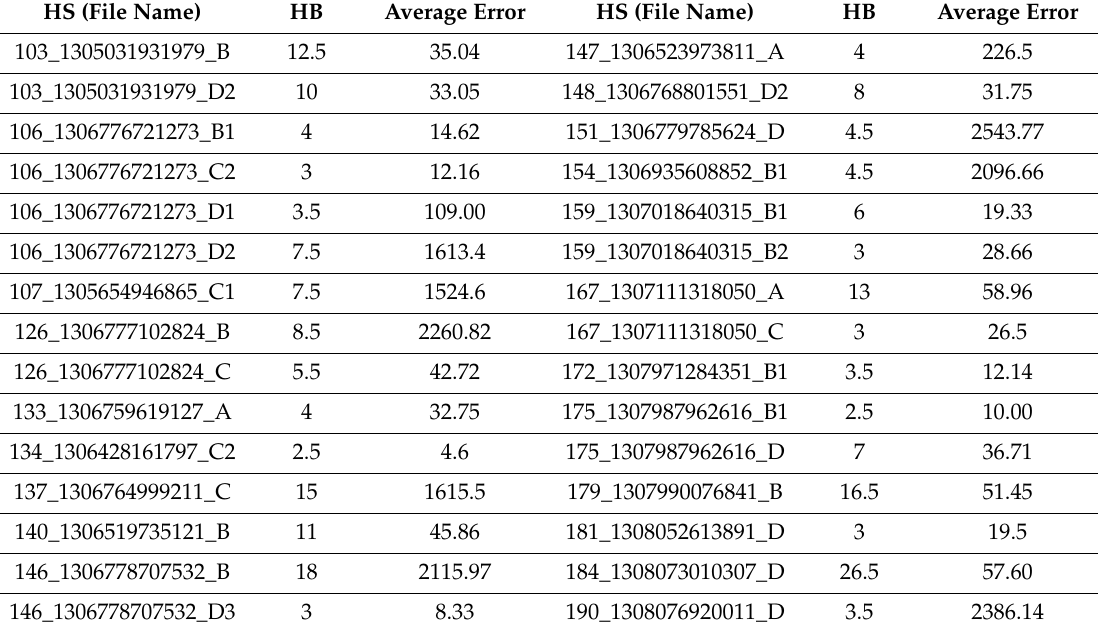
Table 5. Results of segmentation for dataset